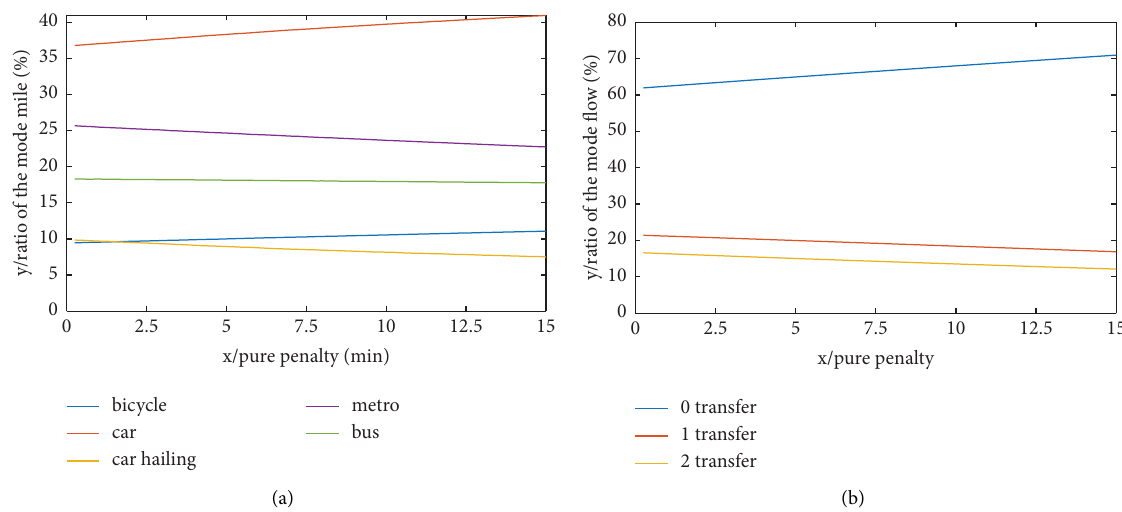
Figure 18: Efect of pure penalty on the fow distribution. (a) Efect of pure penalty on the subnetworks. (b) Efect of pure penalty on the number of